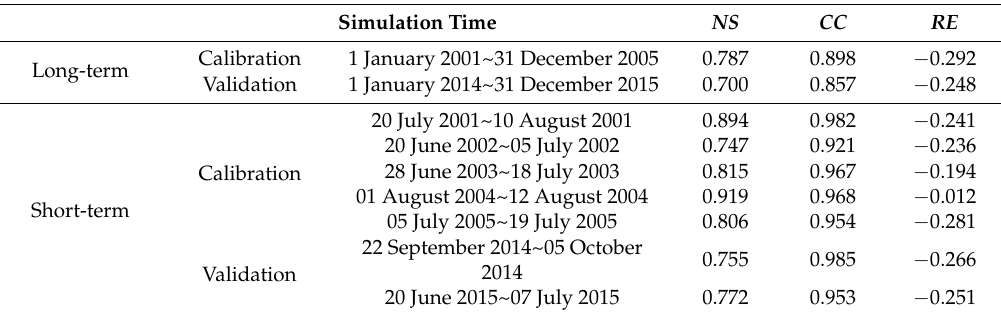
Figure 4. Long-term calibration ( a ) and validation ( b ) of the TOPX model in the WJB watershed and its short-term calibration ( c – g ) and validation ( h , i ). Discharge (mm 3 /s) in the figure indicates discharge at the WJB hydrology station; precipitation (mm) denotes the average precipitation in the WJB watershed that was calculated based on the CMA observations. Table 2. Statistical results of the simulated daily discharges in the WJB watershed during the calibrations and validations of the hydrological model TOPX *.